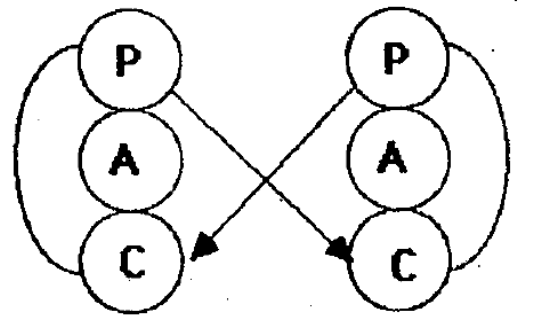
Figure 2: The Parental Flip in Action (Summerton, date unknown,